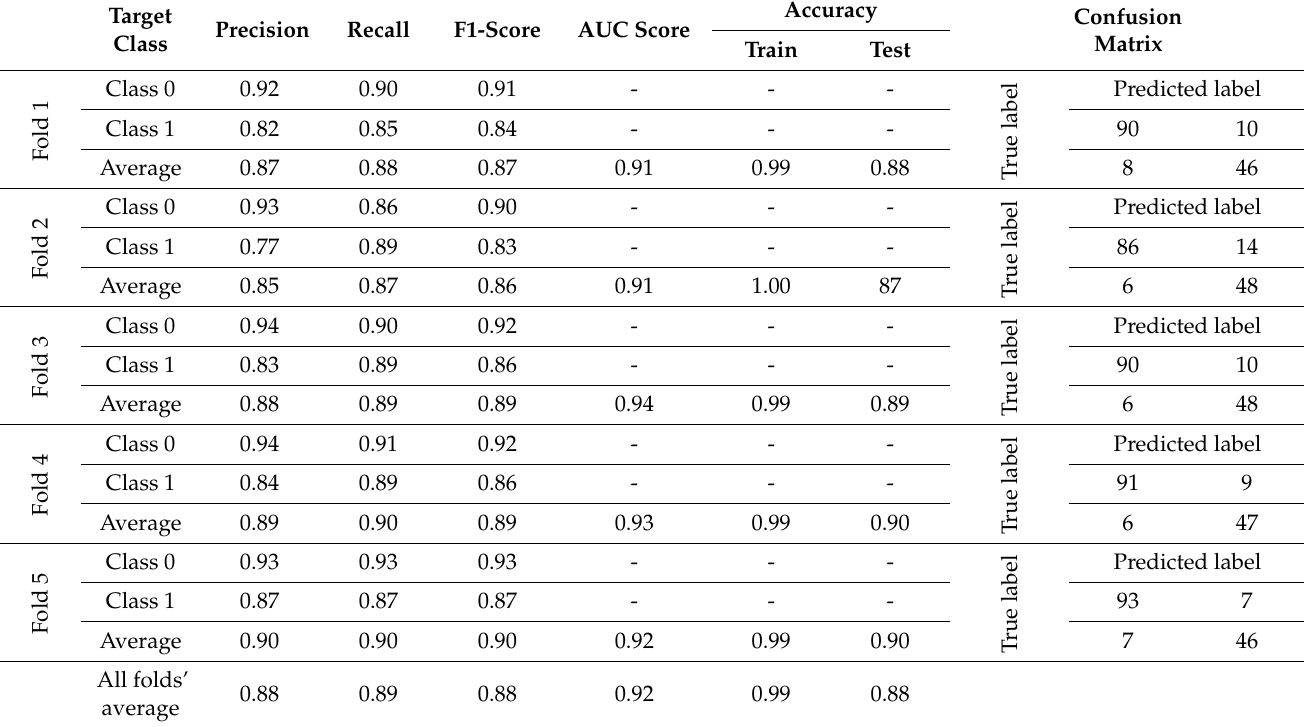
Table A5. XGBoost classifier’s performance for the five-fold